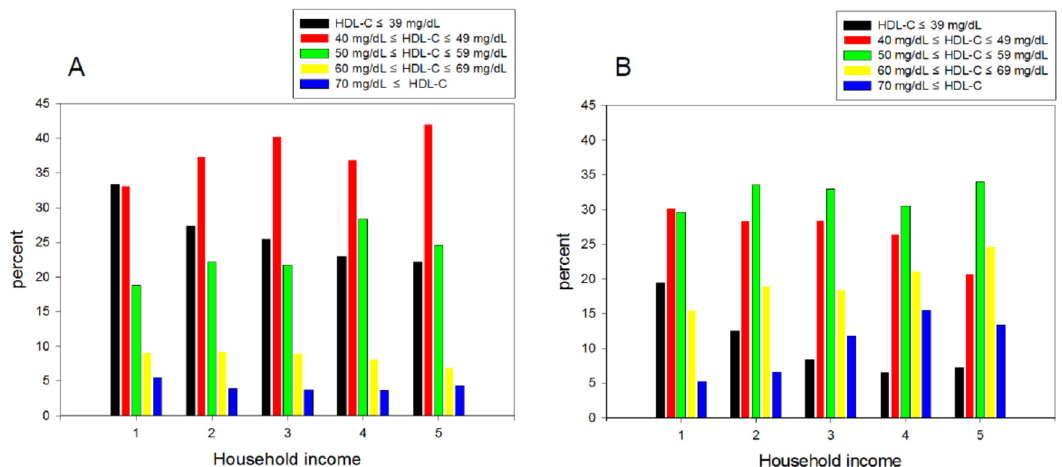
Figure 2. Distribution of high-density lipoprotein cholesterol (HDL-C) category percentage according to household income grade quintile in men ( A ) and women ( B ): KNHANES 2017. Category 1, HDL-C ≤ 39 mg / dL. Category 2, 40 mg / dL ≤ HDL-C ≤ 49 mg / dL. Category 3, 50 mg / dL ≤ HDL-C ≤ 59 mg / dL. Category 4, 60 mg / dL ≤ HDL-C ≤ 69 mg / dL. Category 5, 70 mg / dL ≤ HDL-C.